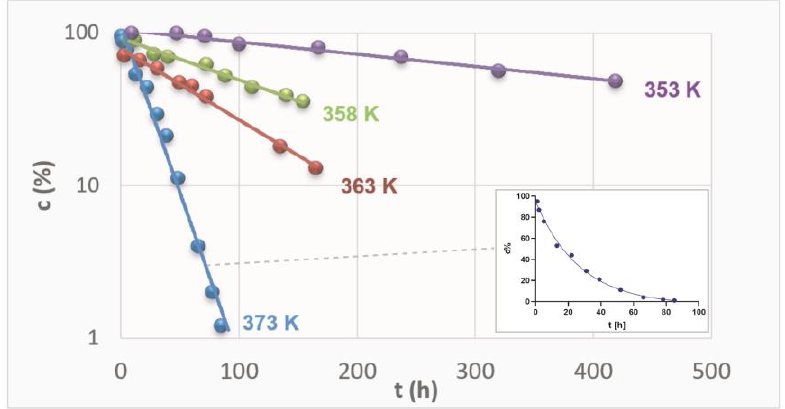
Figure 2. Semi-logarithmic plots c t = f(t) describing degradation of RAM in solid state under dry air conditions at different temperatures.